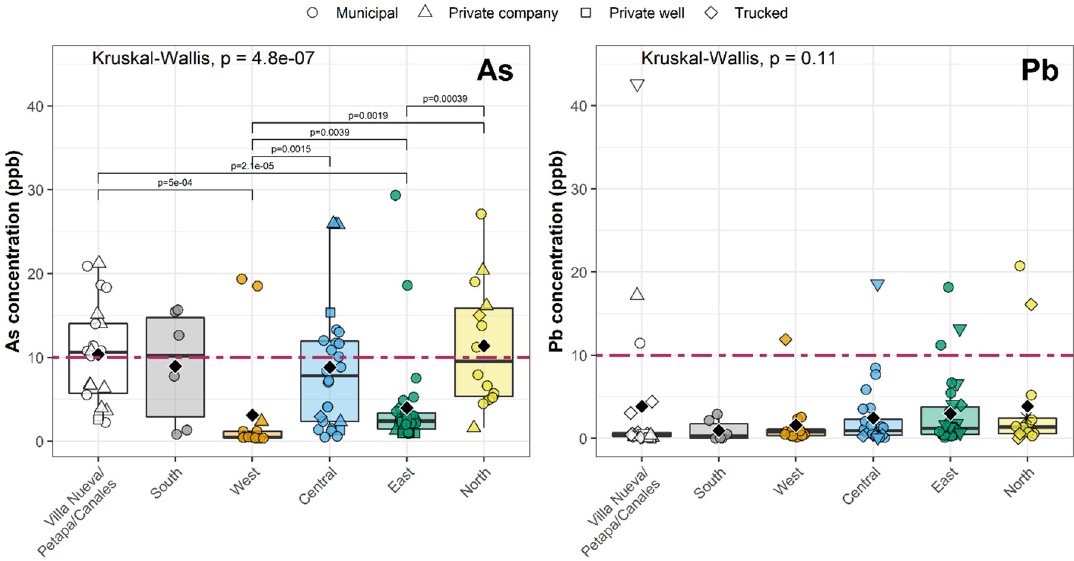
Figure 4. Distribution of As and Pb concentrations in first-draw tap water throughout the Guatemala City metropolitan area. Horizontal lines of each box indicate the first quartile, median, and third quartile for each metal; vertical lines indicate the spread of the data up to ± 1.5 times the interquartile range. Black diamonds show the mean value. Dashed red lines indicate the MPL for As and Pb. Pairwise comparisons highlight significant differences (adjusted for multiple comparisons) between geographic areas using Wilcoxon tests. As showed significant differences between different parts of the city, but Pb did not. Kruskal–Wallis tests evaluate the overall significance of the geographic area on As and Pb concentrations.